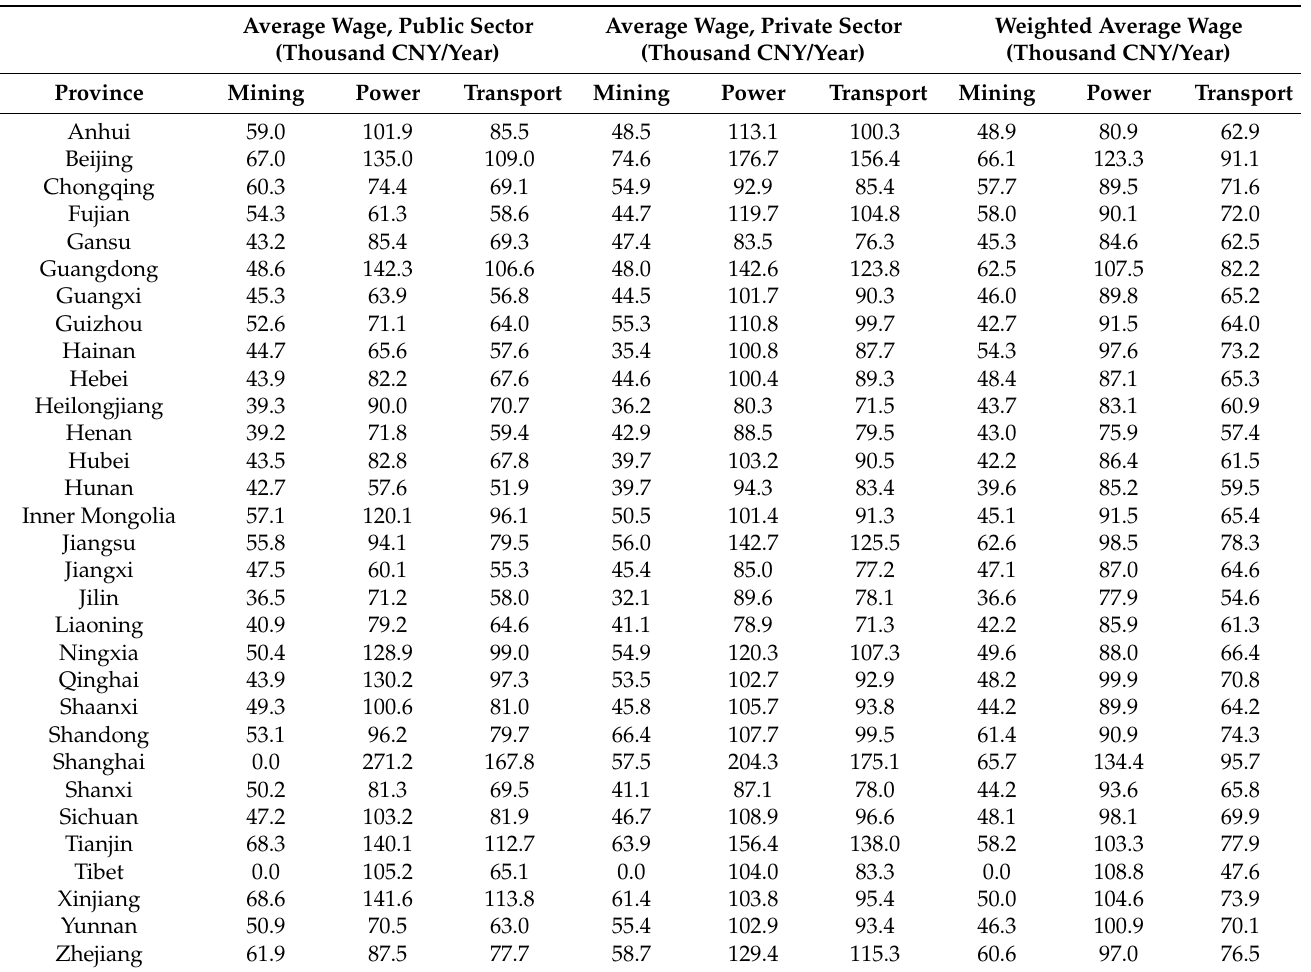
Table A13. Income tax brackets, rates, and quick deductions. Taxable Income (T, Thousand CNY) Rate (%) Quick Deduction (Thousand CNY)